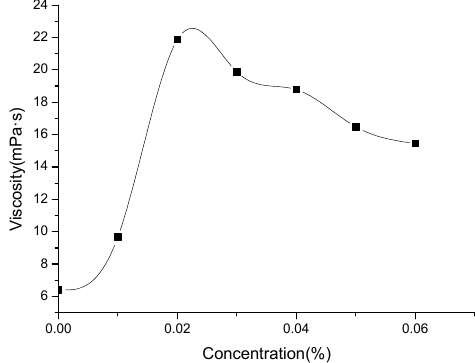
Figure 9. Effect of nano-MgO concentration on the viscosity of 4.0 wt.% DS18-3-18.